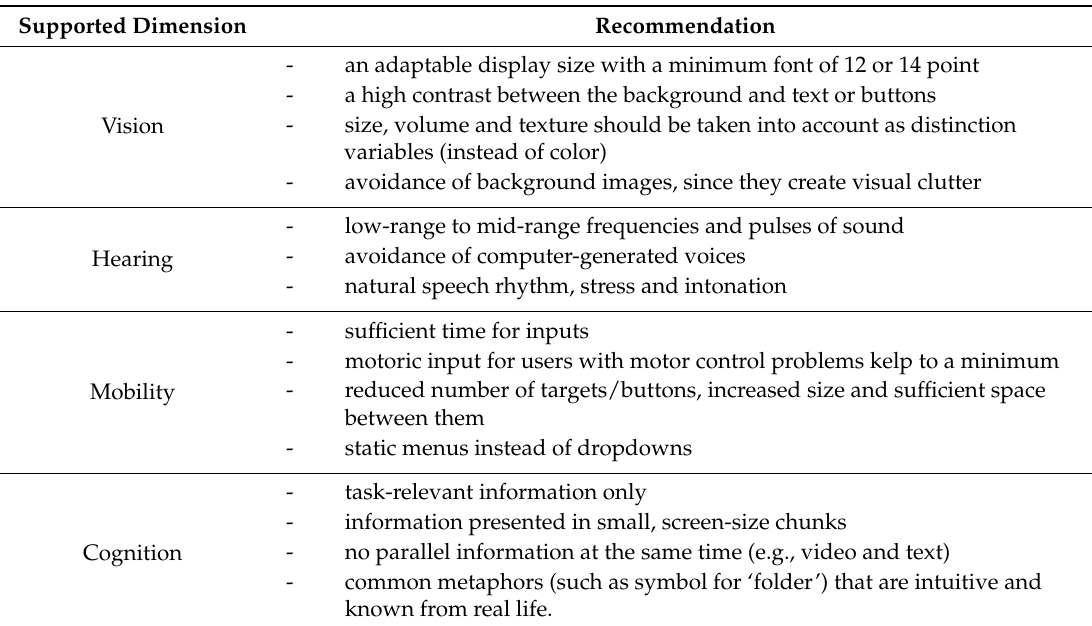
Table 3. Design guidelines for interfaces for elderly users, adapted after [3] (pp.